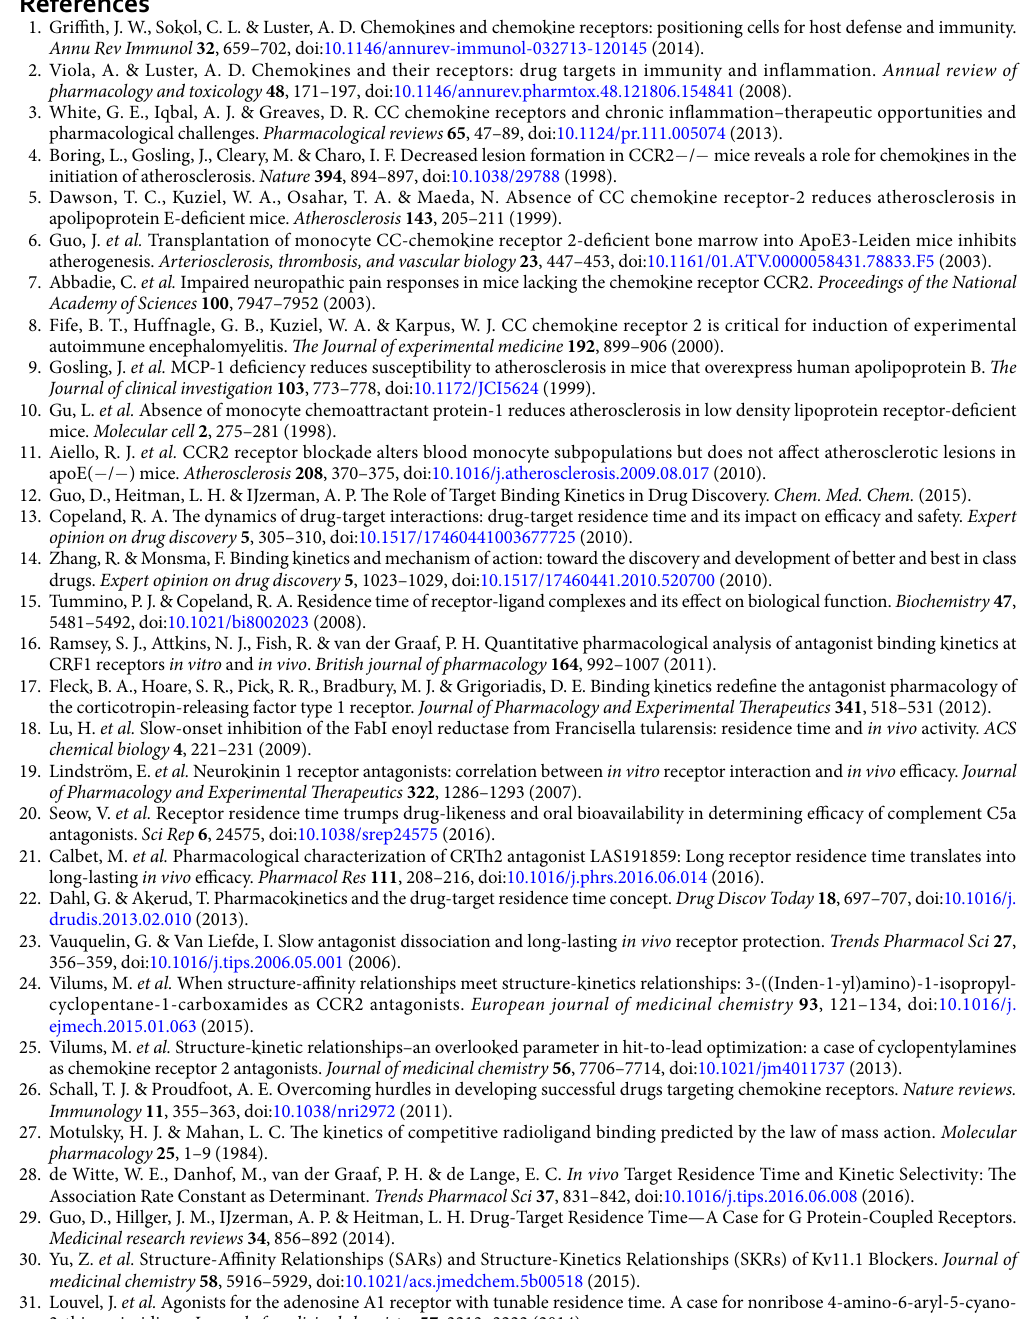
Parameter values: for the simulations in Fig. 8b, k el was set to 0.0647 hr − 1 , based on the slope of the linear regression of the pharmacokinetic data (Fig. 8a). On basis of in-house measurements, k off was set to 3.06 hr − 1 (corresponding to 0.051 min − 1 , as shown in Table 1) and the K D was set to 10 nM, which corresponds to the K i value of 15a determined in [ 3 H]INCB3344 displacement assays. The K i value was used instead of the K D (from Table 1) as this represents a more conservative choice with regard to target saturation. The receptor concentration was set to an arbitrarily low number of 1